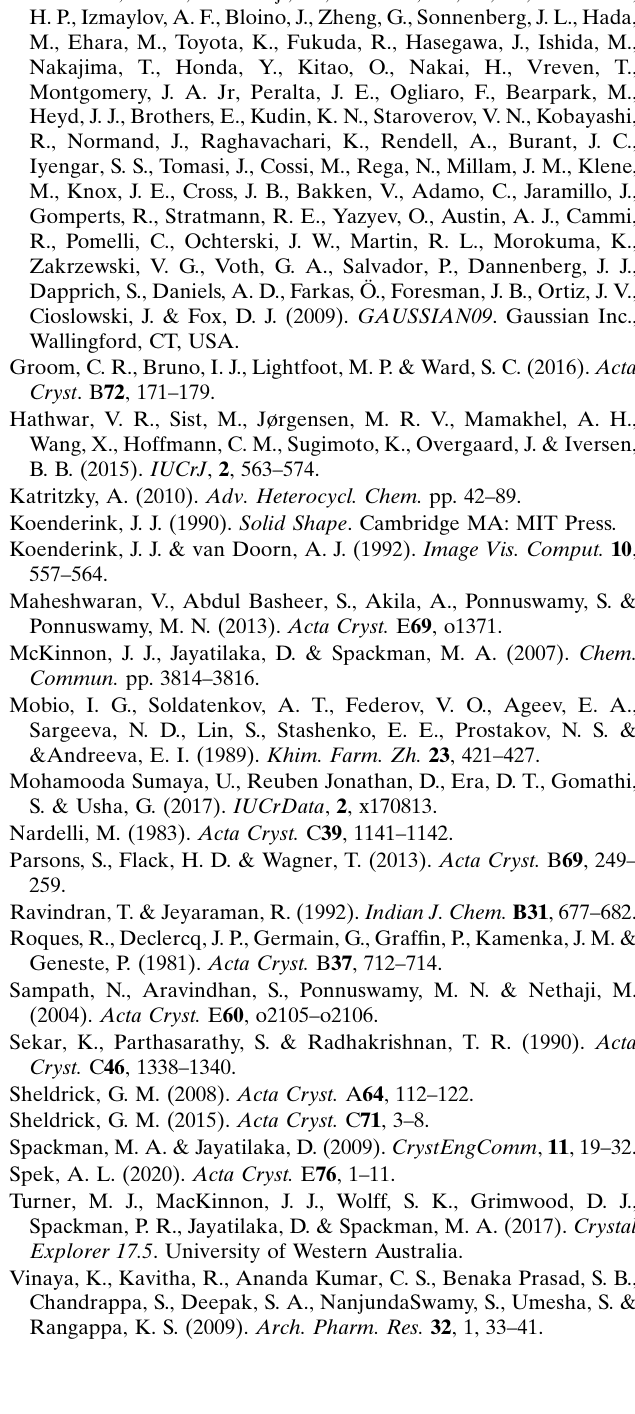
Table 3 Experimental details. Crystal data Chemical